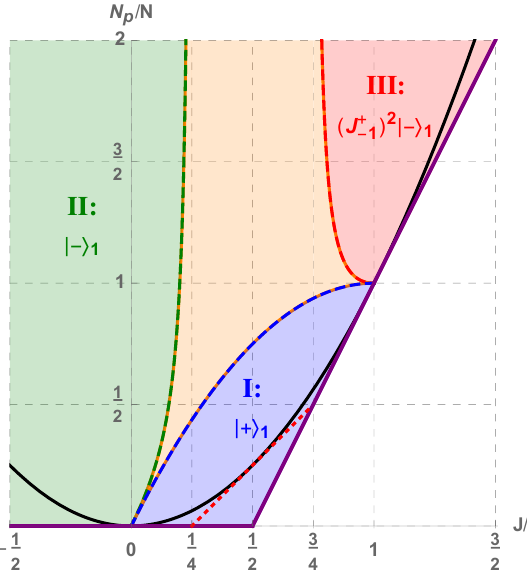
. In the orange region, no 4 forms (cid:1) (2) > 0. 1 ) 2 j(cid:0)i forms and (cid:1) (3) > 0. Above the solid (cid:0) 1 1